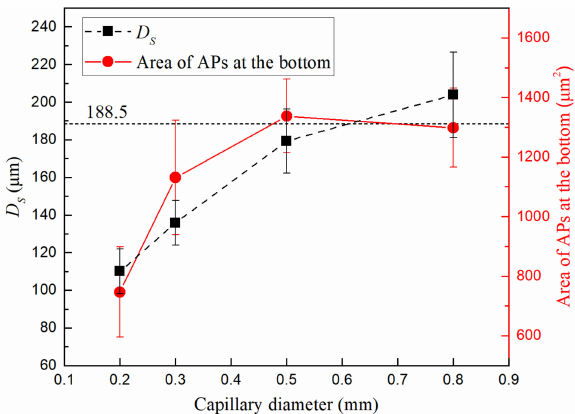
Figure 4. D S in different diameter ( d = 0.2 mm, 0.3 mm, 0.5 mm, 0.8 mm) capillary tubes. The horizontal dashed line is the diameter of the microbubbles produced on the slide under the same experimental conditions. The area of APs at the microbubble bottom was drawn with a red solid line. c = 3.0 × 10 6 cm − 3 . P = 189 mW.